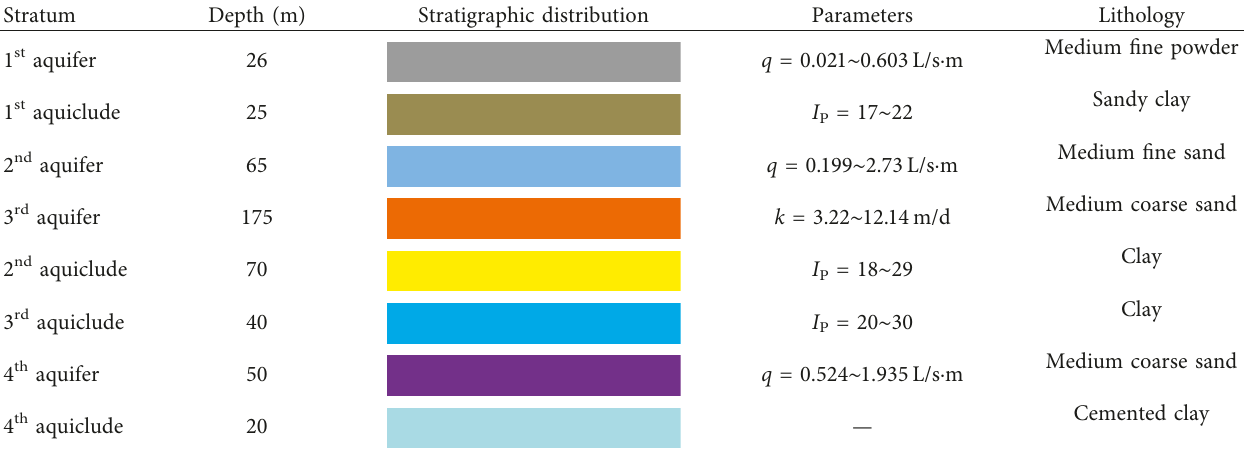
Table 1: Structural composition of the weakly cemented stratum in Xieqiao mining area.